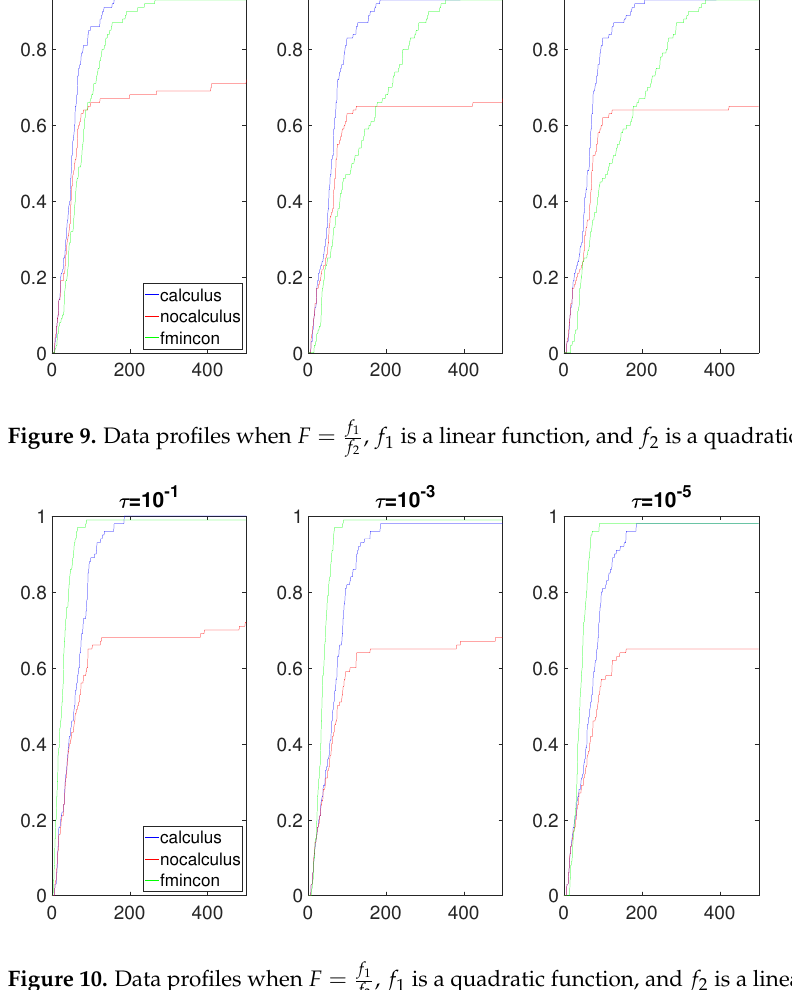
Figure 10. Data profiles when F = f 1